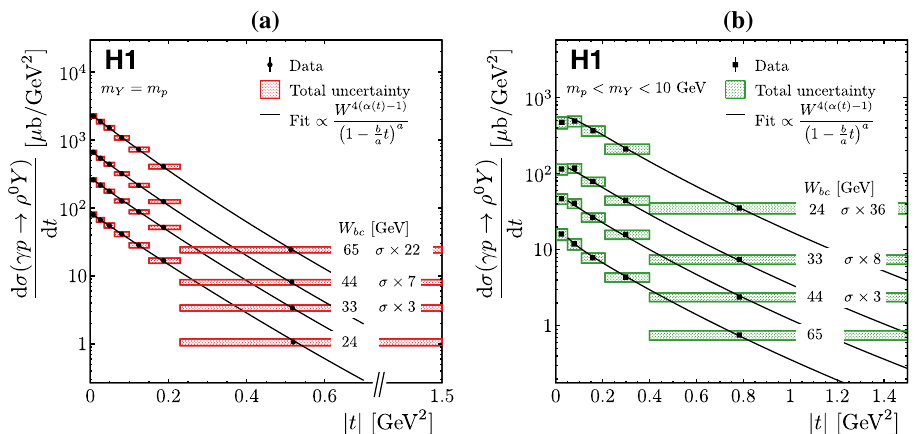
Fig. 17 Elastic ( m Y = m p ) ( a ) and proton-dissociative ( m p < m Y < 10 GeV) ( b ) differential ρ 0 meson photoproduction cross sections d σ(γ p → ρ 0 Y )/ d t in bins of W γ p and as functions of t . Individual distributions are scaled for visual separation, as indicated.